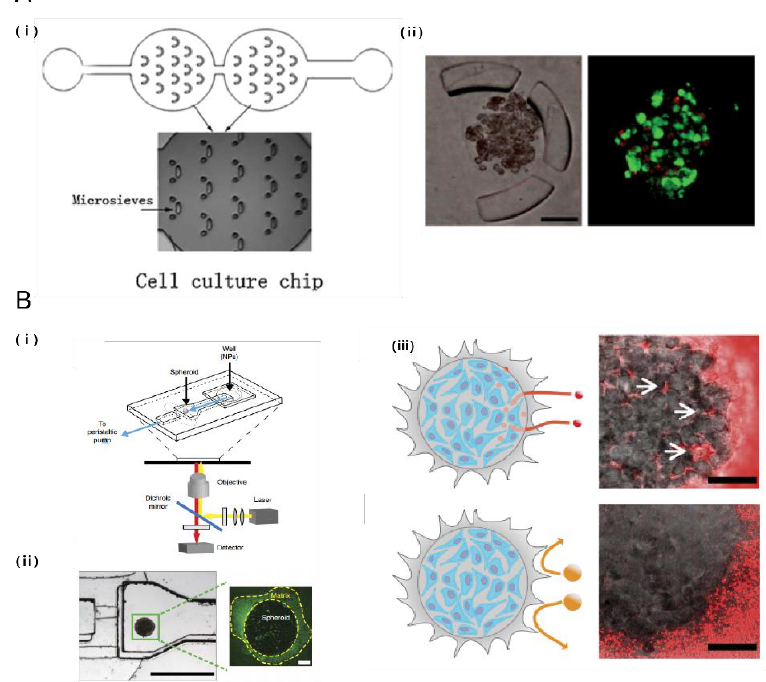
Figure 6. Probing the efficacy of drug delivery using TME on a chip. ( A ) Droplet-based microfluidic system for multicellular tumor spheroid formation and anticancer drug testing. (i) Schematic of the droplet formation and cell culture microfluidic chips. Each chamber contains 14 sieves for alginate droplet trapping; (ii) Breast tumor cells proliferating and forming multicellular spheroids while encapsulated in alginate beads. Tumor cells were perfused with doxorubicin and live/dead assay was assessed [75]. Scale bar: 100 μm; ( B ) Tumor on a chip provides an optical window into nanoparticle tissue transport. (i) Schematic of the microfluidic device; (ii) MDA-MB-435 breast cancer cell embedded within microfluidic device (iii) Effect of nanoparticle size on tissue accumulation. 40 nm fluorescent PEG-nanoparticles entered the tumor spheroid and accumulated in the interstitial spaces but 110 nm nanoparticles were excluded from the spheroid [93]. Scale bar: 100 μm. Reproduced with permission.